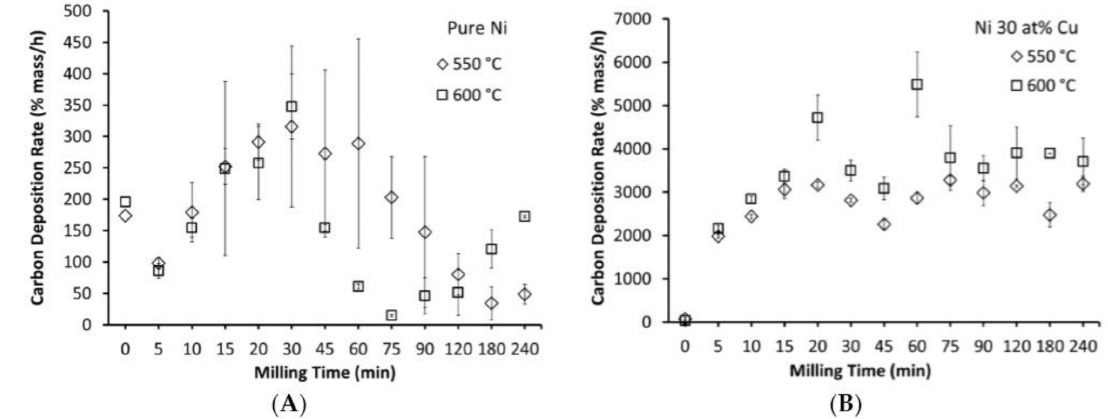
Figure 4. Carbon deposition rates catalyzed by ( A ) Ni and ( B ) Ni 30 at % Cu milled for varying durations at different temperatures. Samples “milled” for 0 min correspond to no mechanical alloying conducted. Error bars represent one standard deviation from the